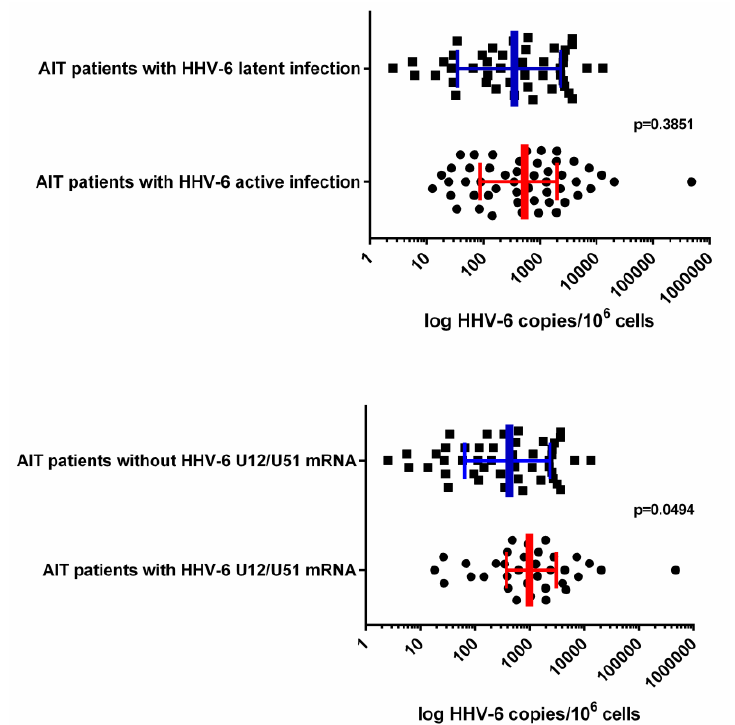
Figure 2. Median HHV-6 load (error bars indicating IQR) detected in AIT patients’ thyroid gland Table 6. Load was indicated as log HHV-6 copies per 10 6 cells. HHV-6 U12 and U51 encode viral homologs of cellular G-protein-coupled receptors.